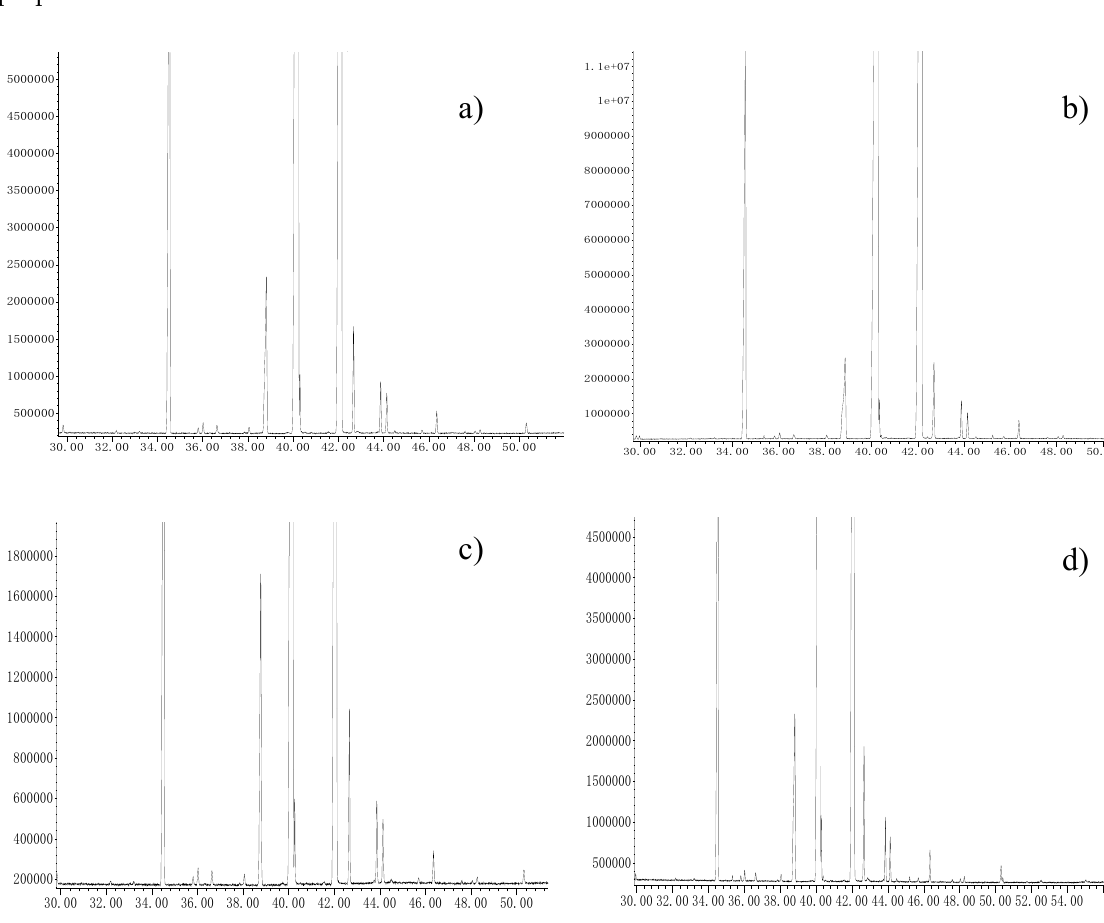
Figure 3. The ion chromatograms of fatty acids of C. sinensis seed oil extracted by ( a ) Soxhlet extraction (SE); ( b ) Microwave-assisted extraction (MAE); ( c ) Cold-pressing extraction (CPE); ( d ) Subcritical fluid extraction (SbFE).